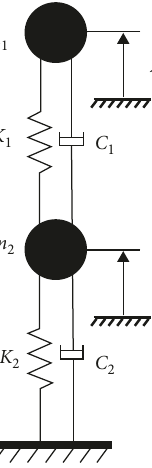
Figure 4: Simplified diagram of calculation model for the foun- dation of stone cutting